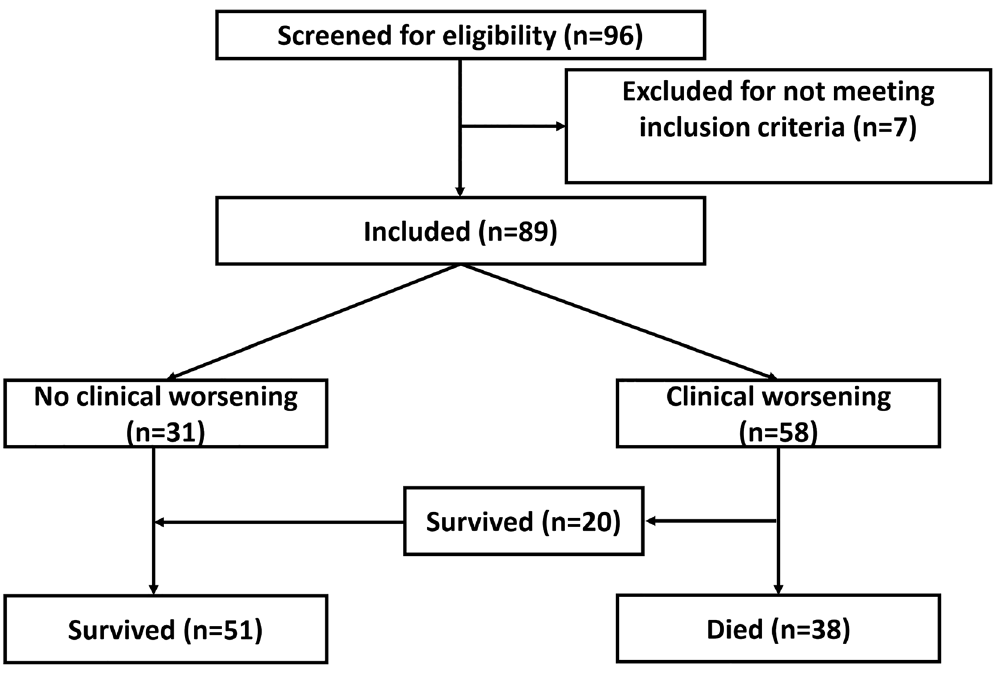
Figure 1. Patient’s